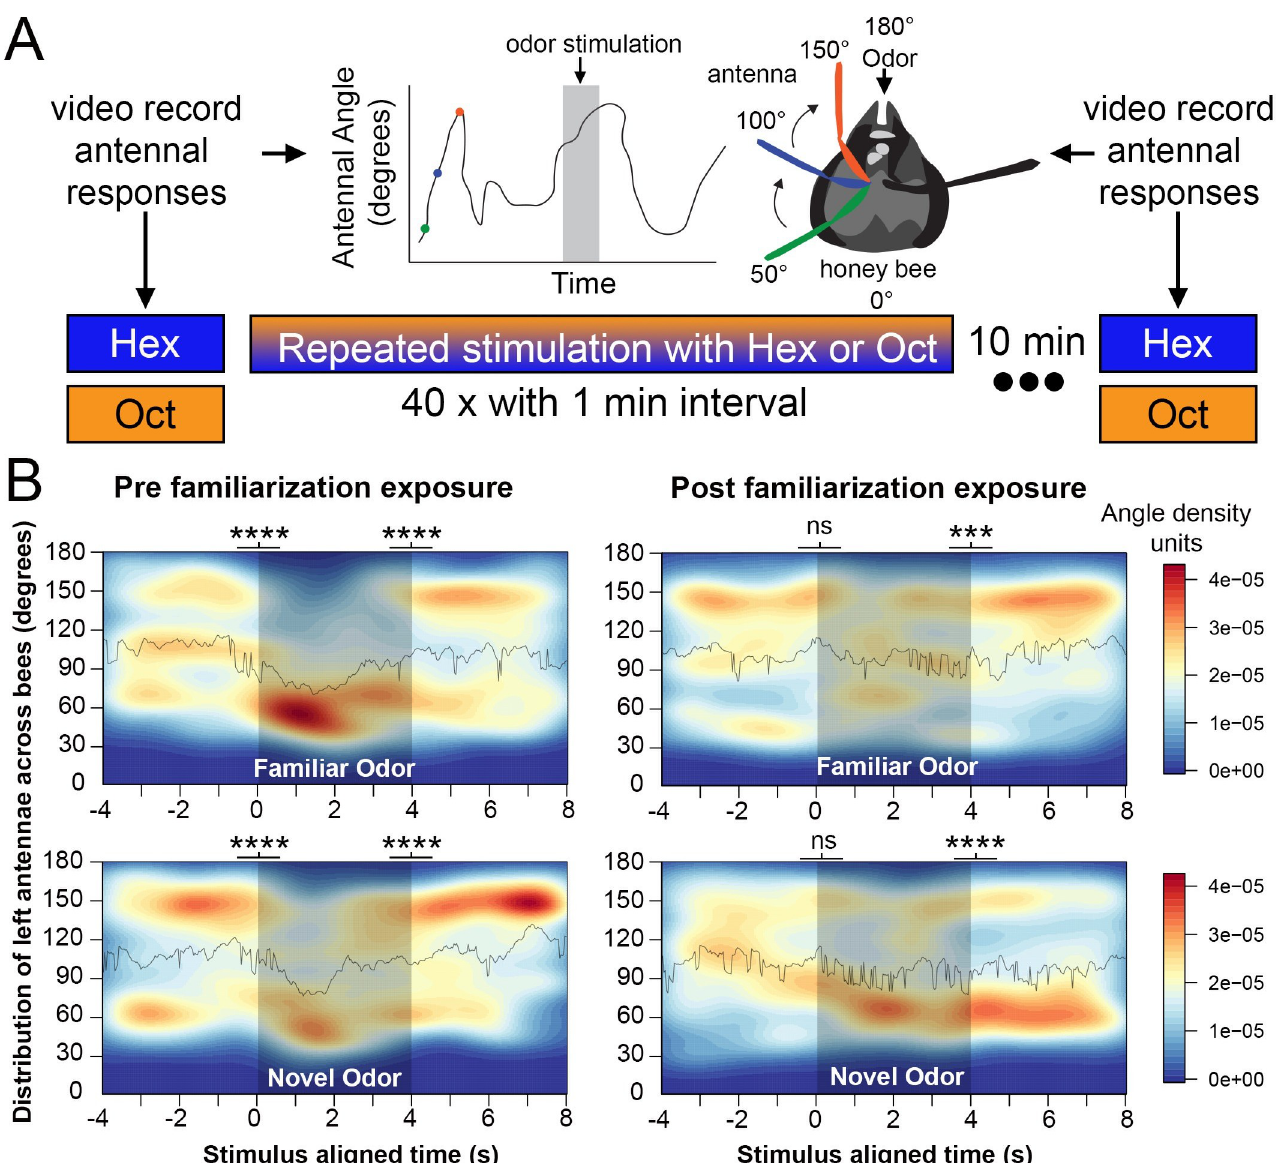
Fig 1. Left antenna responses to novel and familiar odors. ( A ) The familiarization protocol using either Hexanol or Octanone as the repeatedly presented unreinforced odor stimulus. Tests were performed with each odor prior to and after familiarization. The headspace is divided into a clockwise circular range of 180 degrees for each antenna. ( B ) The average distribution densities of left antennae’s angular positions in response to odors before the familiarization process (left column plots) and 10 min after the familiarization process (right column plots). Plots are aligned by odor onset over 12 s, which includes 4 sec segments before, during and after odor delivery (360 frames; N = 24 animals, 13 Hex exposed, 11 Oct exposed). In both columns, the top plot shows responses to the familiar odor and the bottom plot shows responses to the novel odor. The solid line in each plot represents the mean angle of the left antenna across all 24 bees for each respective odor. The shaded region indicates the period during odor stimulus presentation. The colored scale to the right of the plots shows the standardized Kernel density scale across all plots. For statistical comparisons angular position was normalized by calculating the difference in the left antenna’s angular position at all time points from the mean antennal angle (when no odor present) across the three time-sections for each bee and odorant presentation. Statistical analyses: Two-way ANOVA, difference measure~ time period � odor, df = 2, n = 24, Tukey HSD post-hoc comparison, asterisks indicate statistical significance, ���� p < 0.00001, ns indicates not